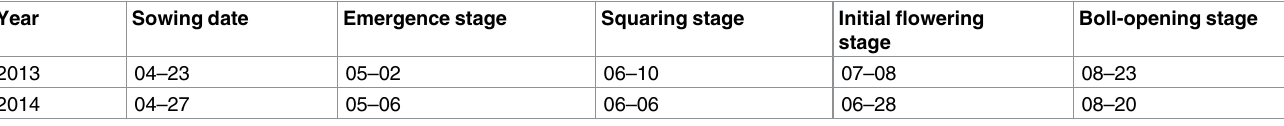
Table 2. Cotton growth period in 2013and